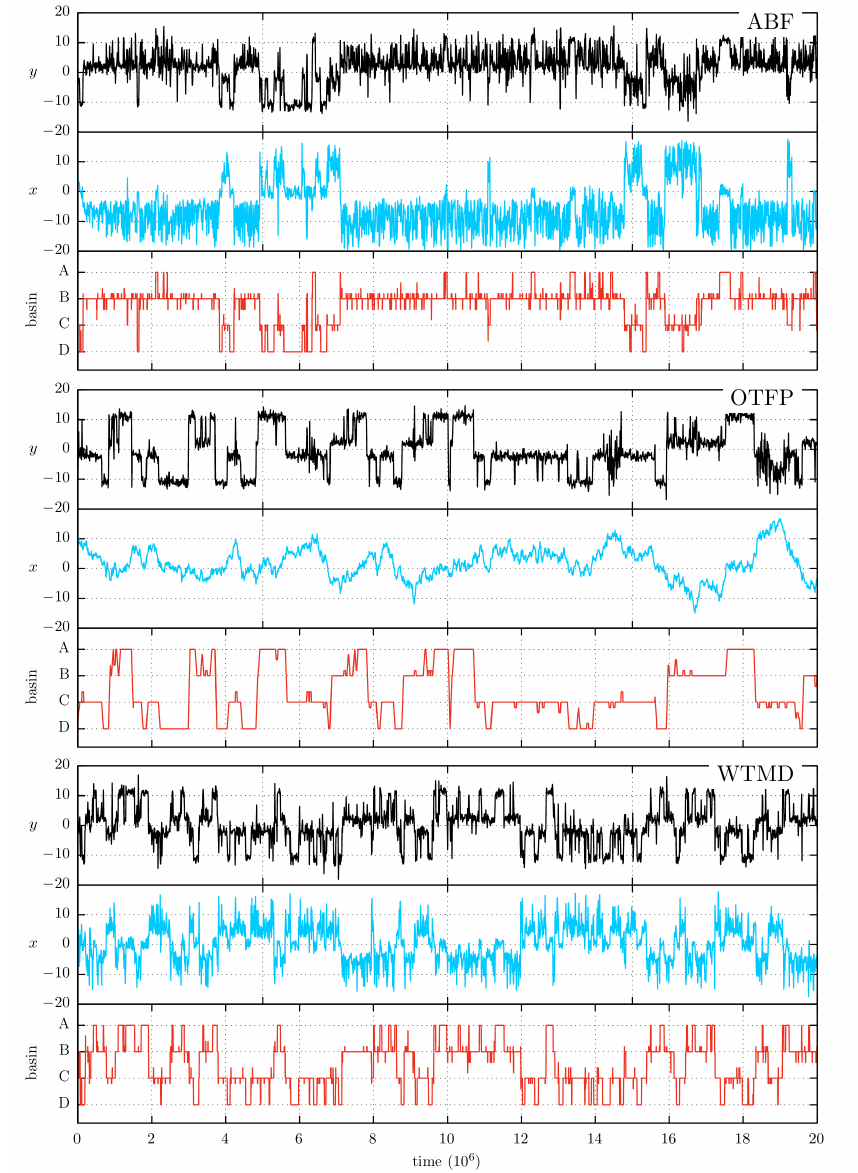
Figure 7. The position trace of representative ABF, OTFP and WTMD simulations associated with the results shown in Figure 6. For each method, x , y and basin assignation are shown in black, blue and red